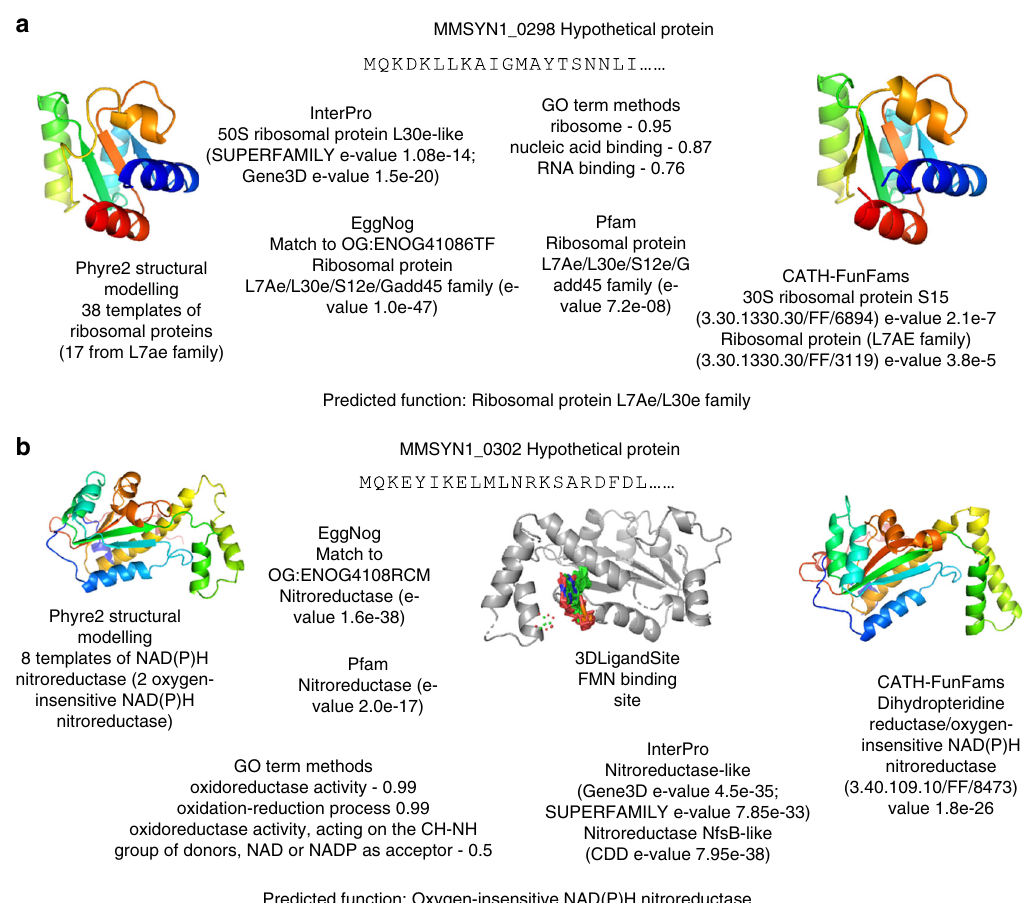
Fig. 6 Con fi dent predictions of protein function in the minimal genome. Both a MMSYN1_0298 and b MMSYN1_0302 were previously classi fi ed as hypothetical proteins. The results from prediction methods and the function assigned are shown